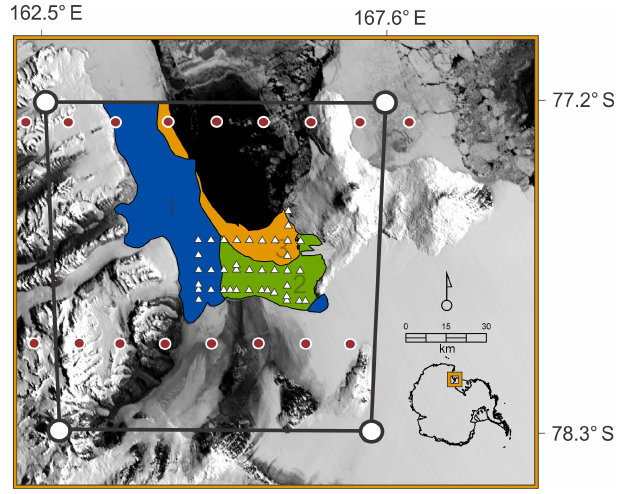
Figure 1. McMurdo Sound study area with each fastening area as identified by Envisat radar imagery: area 1 – 1 April 2011 (blue), area 2 – 29 April 2011 (green), area 3 – 1 June 2011 (orange). The SnowModel domain bounded by the black box. Fastening areas are superimposed on a MODIS image acquired on 15 November at the time of maximum fast ice extent in 2011. The locations of 39 mea- surement sites used to produce the in situ snow and sea ice statis- tics are shown as white triangles. The centre points of each ERA-I 0 . 75 ◦ × 0 . 75 ◦ grid cell in the vicinity of the study area are displayed as red